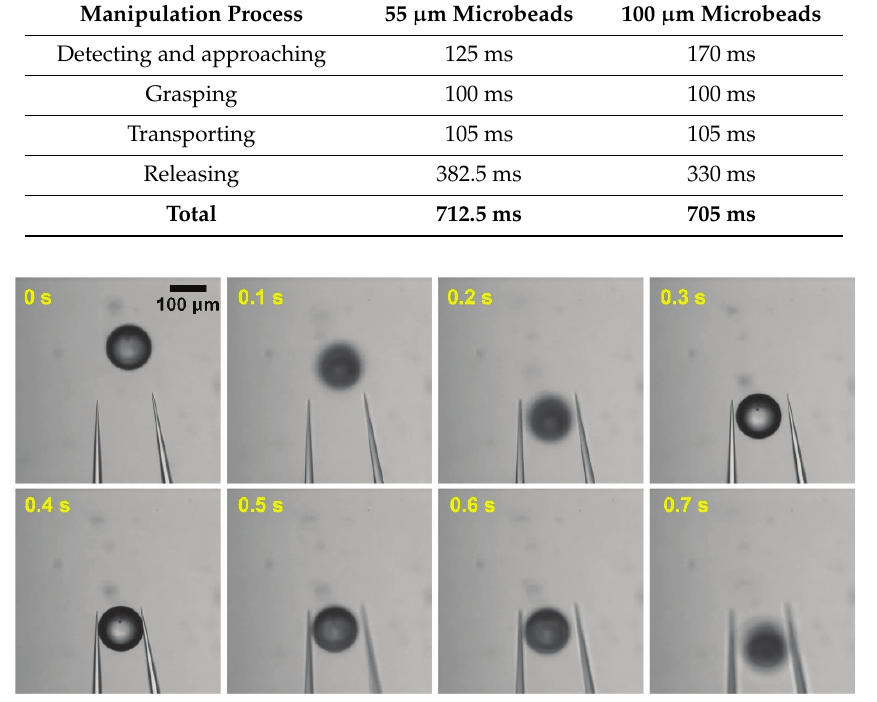
Figure 10. Time-lapse images of the automated manipulation of an Figure 10. Time (cid:556) lapse images of the automated manipulation of an object. (cid:3) Table 2. Average required time for manipulation of 55 μ m and 100 μ m microbeads.